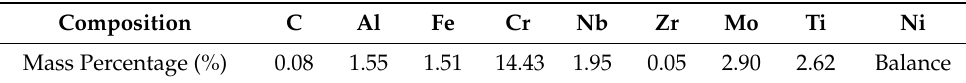
Table 1. Composition of the GH4698